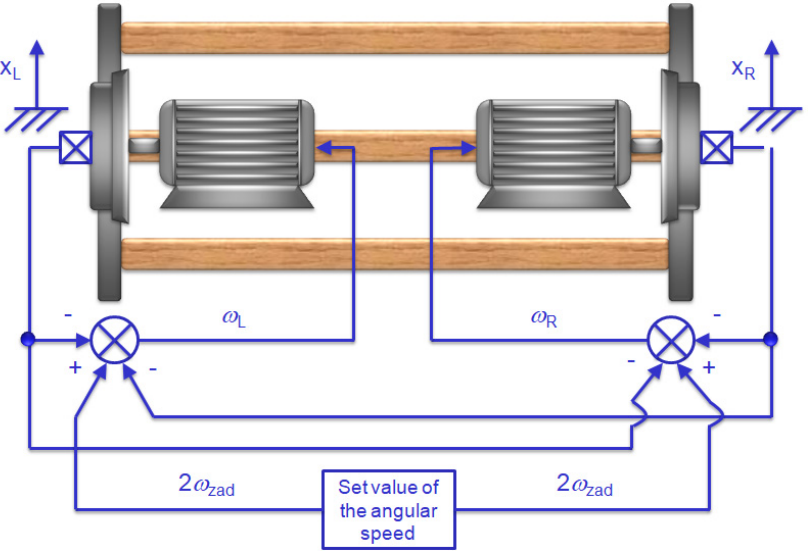
Figure 15. Block diagram for setting the rotational speed of a single wheelset.